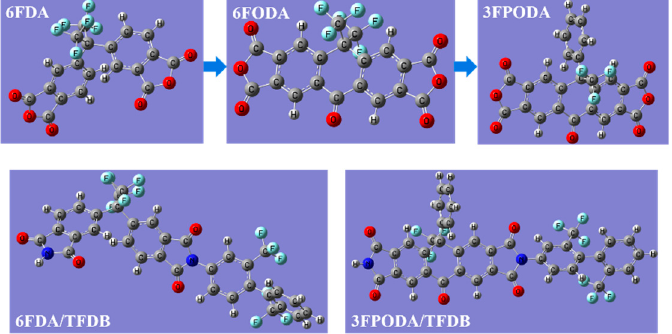
Figure 1. The molecular simulation of monomer 3FPODA, 6FDA, and structural units 3FPODA/TFDB and